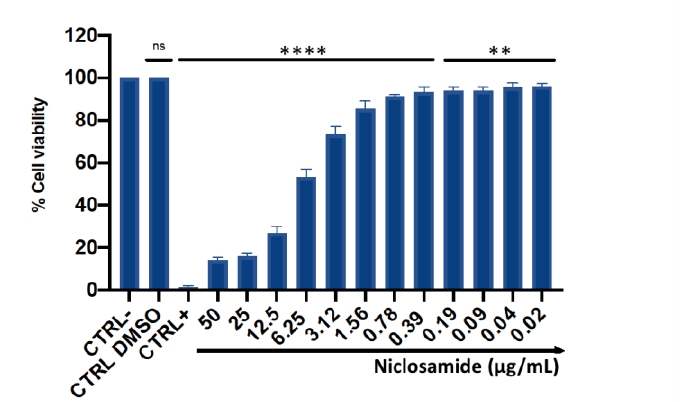
Figure 5. HaCaT cell viability after 24 h of treatment with niclosamide. CTRL-: untreated cells; CTRL+: dimethyl sulfoxide (DMSO) used at toxic concentration; CTRL DMSO: solvent used to dis- solve the drug. The data represent the mean ± SD. Dunnett’s multiple comparisons test: **** p < 0.0001; ** p < 0.0096; ns p > 0.05. Ordinary one-way ANOVA: p < 0.0001, R 2 = 0.9982.